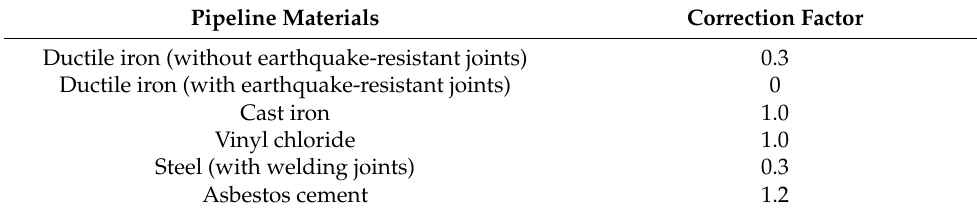
Table 2. Correction factors of pipeline materials